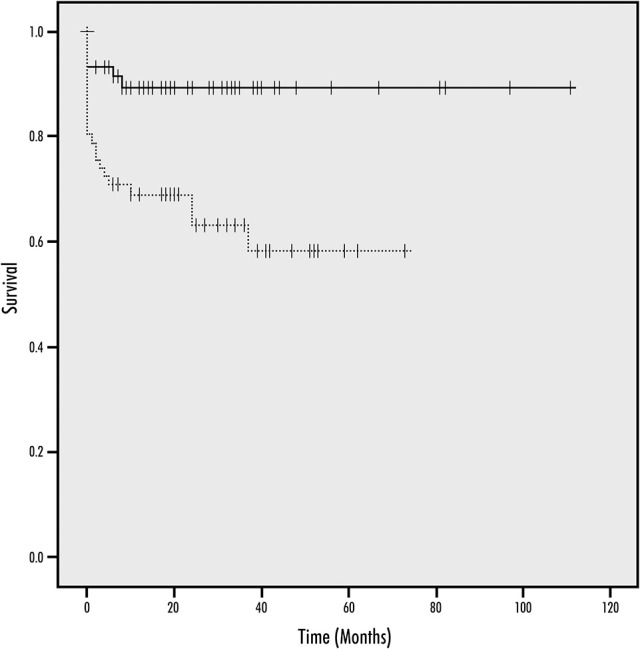
Kaplan-Meier Curves for the cumulative probability of periprocedural ischemic or hemorrhagic stroke and during follow-up (continuous line, anterior circulation; dotted line, posterior circulation; y-axis, survival; x-axis, time in months).